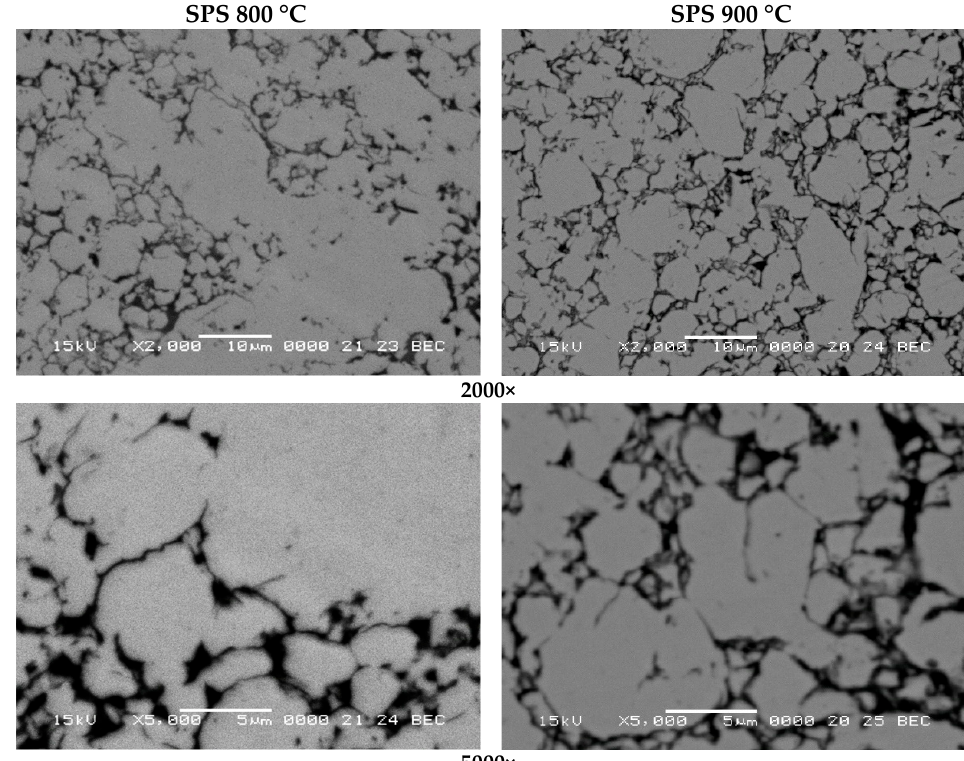
Figure 5. Scanning electron microscopy micrographs, obtained by backscattering electrons’ signal at 2000× and 5000×, of the samples densified at 800 and 900 °C by spark plasma sintering.